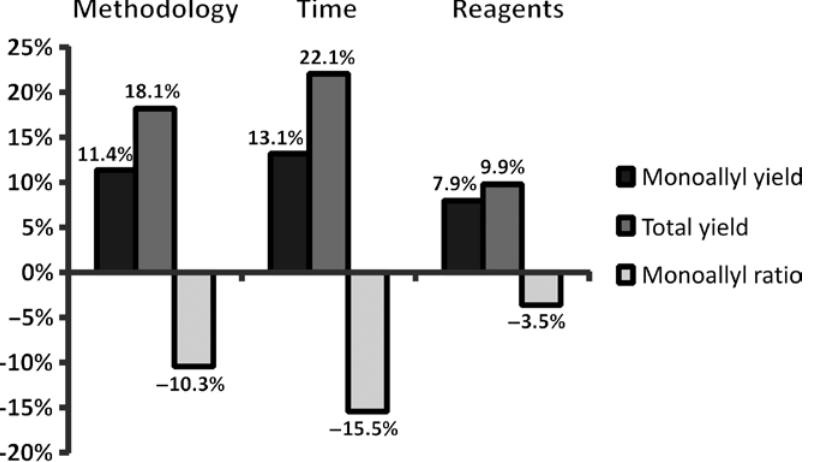
Figure 2: Graphical representation of the effects generated by methodology (conventional to US), reaction time (from 1.5 h to 4 h) and quan- tity of reagents (7.5 mmol to 10.0 mmol of both allyl bromide and K